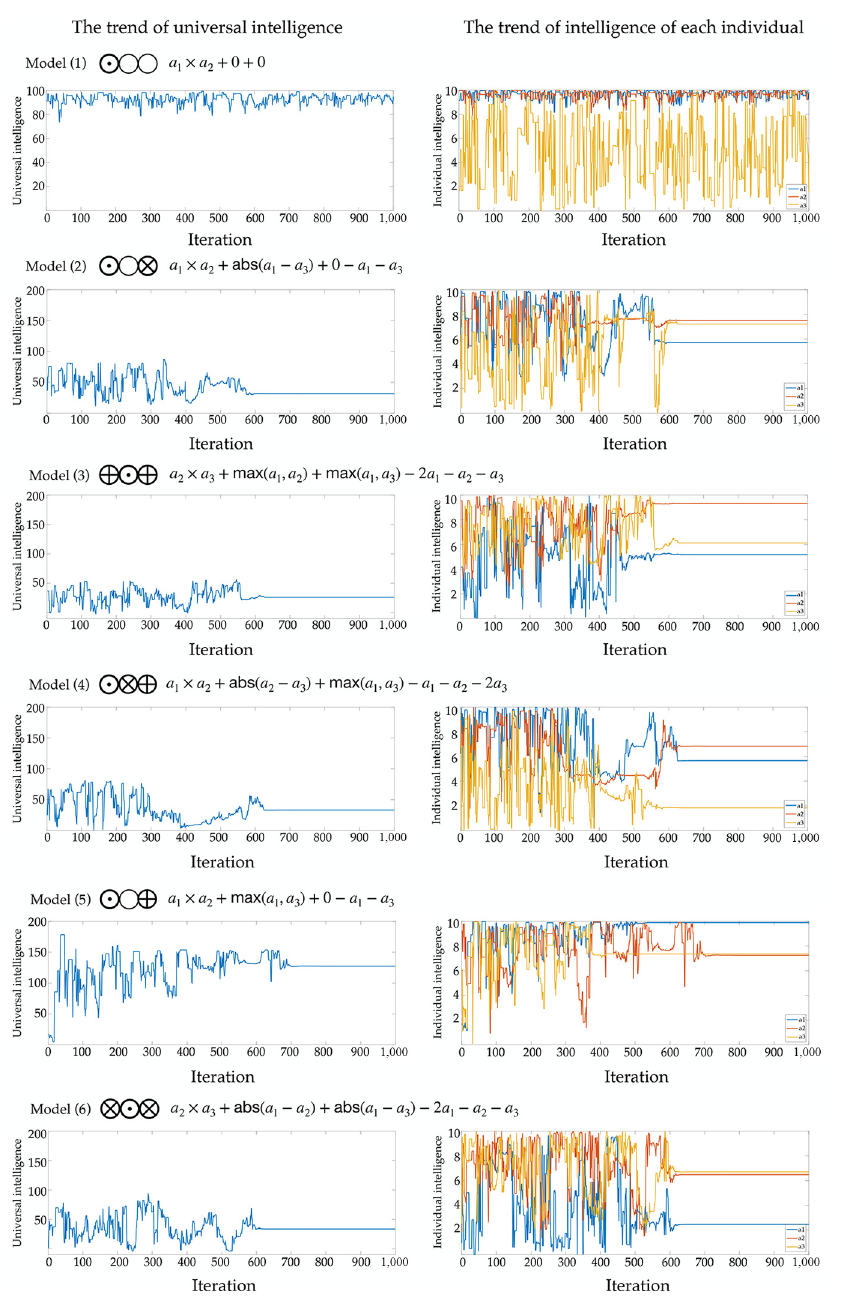
Figure 4. Evolution of crowd intelligence with different interaction patterns over